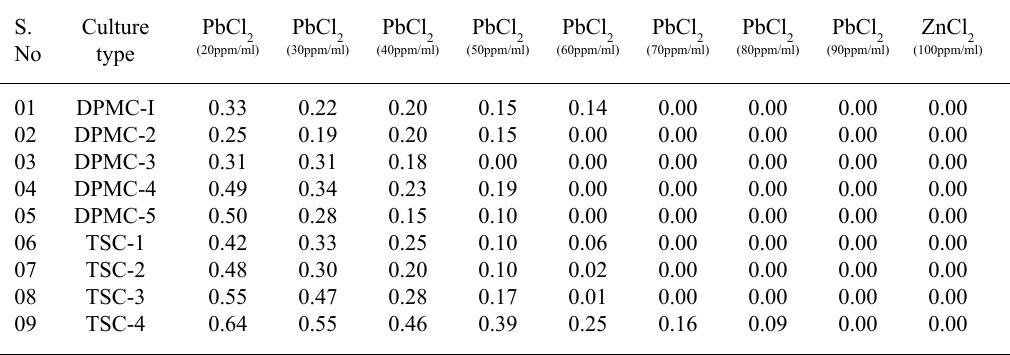
table 5. Effect of Lead on bacterial growth (OD at 620nm)